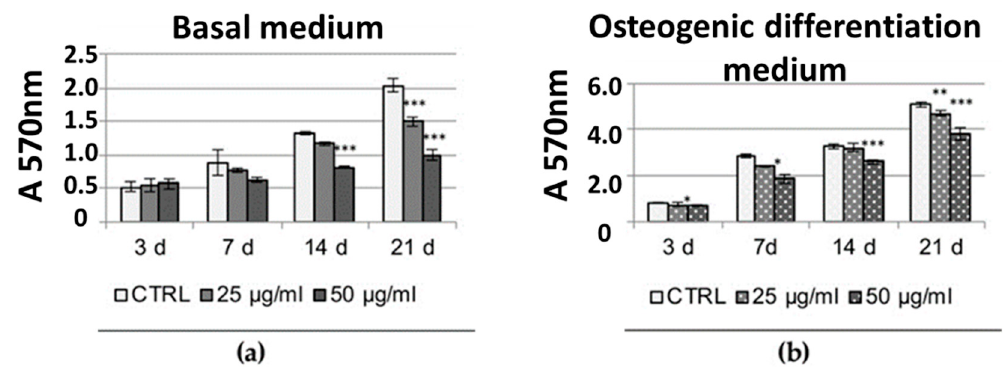
Figure 2. ADSCs viability measured by MTT assay. ( a ) Viability of control ADSCs and ADSCs treated with 25 μ g/mL or 50 μ g/mL of YB at 3, 7, 14 and 21 d of culturing in basal medium. ( b ) Viability of control ADSCs and ADSCs treated with 25 μ g/mL or 50 μ g/mL of YB at 3, 7, 14 and 21 d of culturing in osteogenic differentiation medium. Absorbance was measured at 570 nm. * p < 0.05; ** p < 0.01; *** p < 0.001 vs. CTRL.